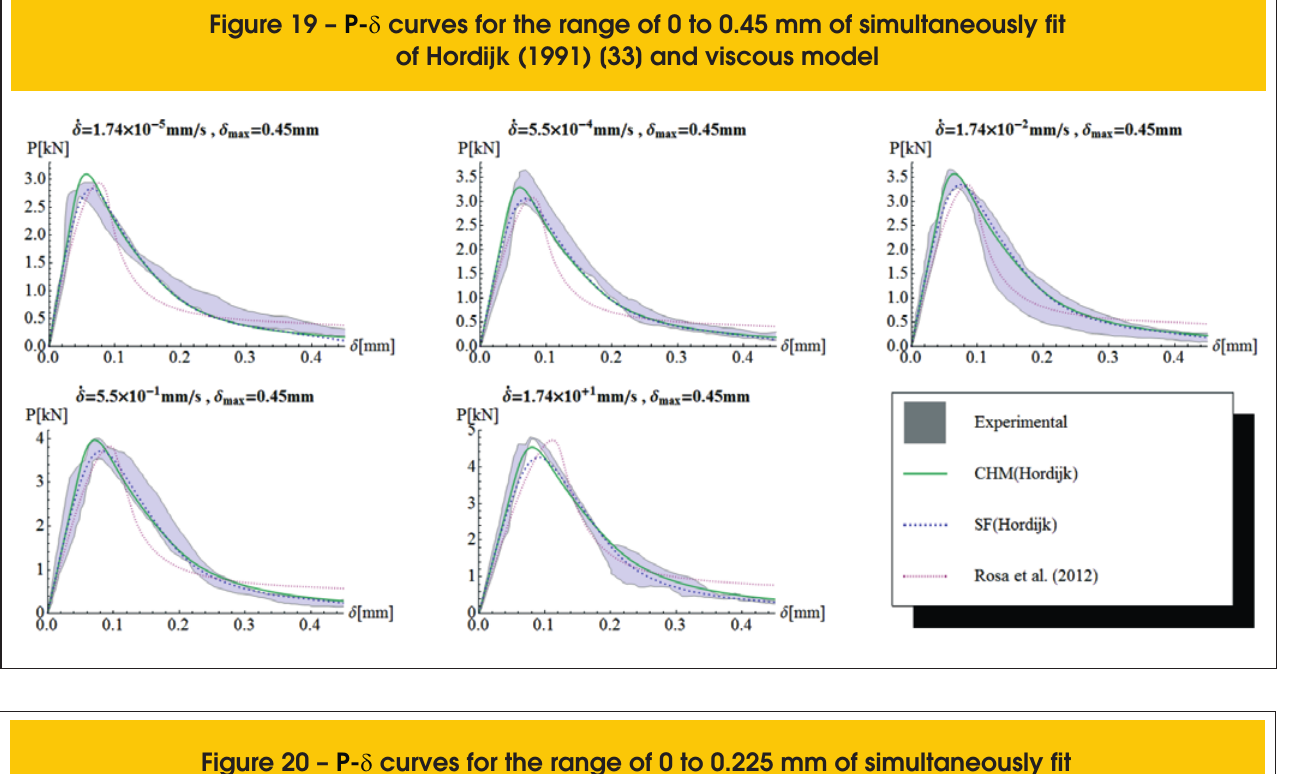
Figure 20 – curves for the range of 0 to 0.225 mm of simultaneously fitP- d of Hordijk (1991) [33] and viscous